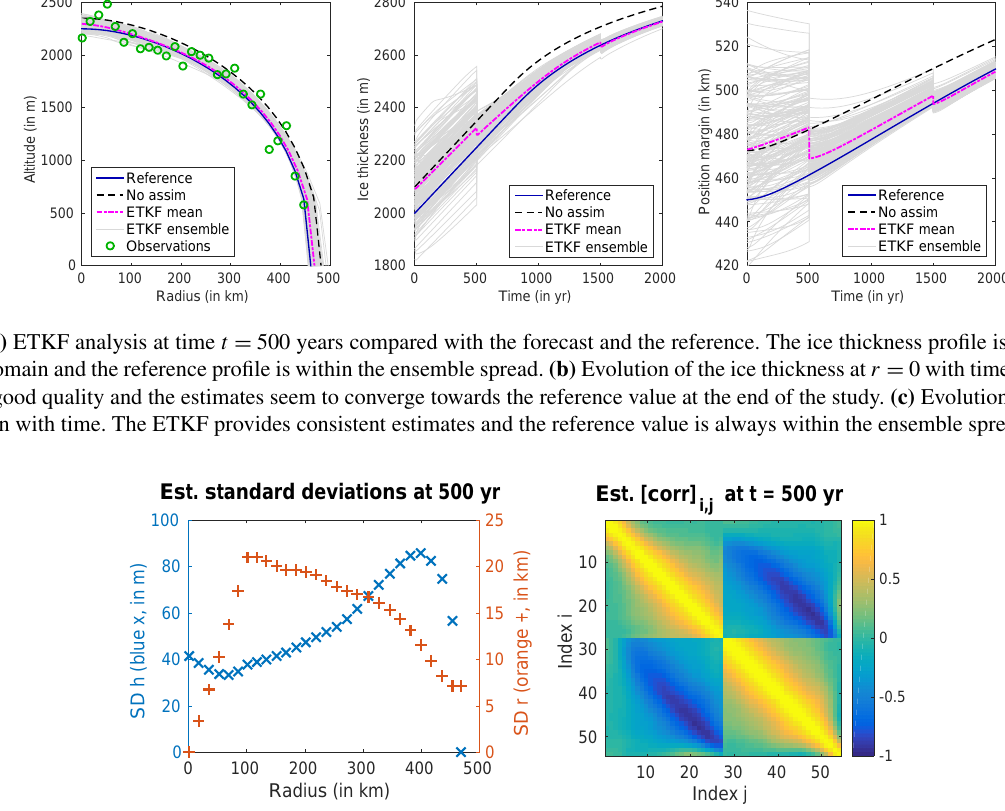
Figure 8. Standard deviations and correlation matrix Corr estimated from the ETKF analysis ensemble at time t = 500 years when we use only observations of ice thickness. Auto-correlations between ice thicknesses are located in the top left corner of Corr ; auto-correlations between node positions are in the bottom right corner. The rest of the matrix depicts the